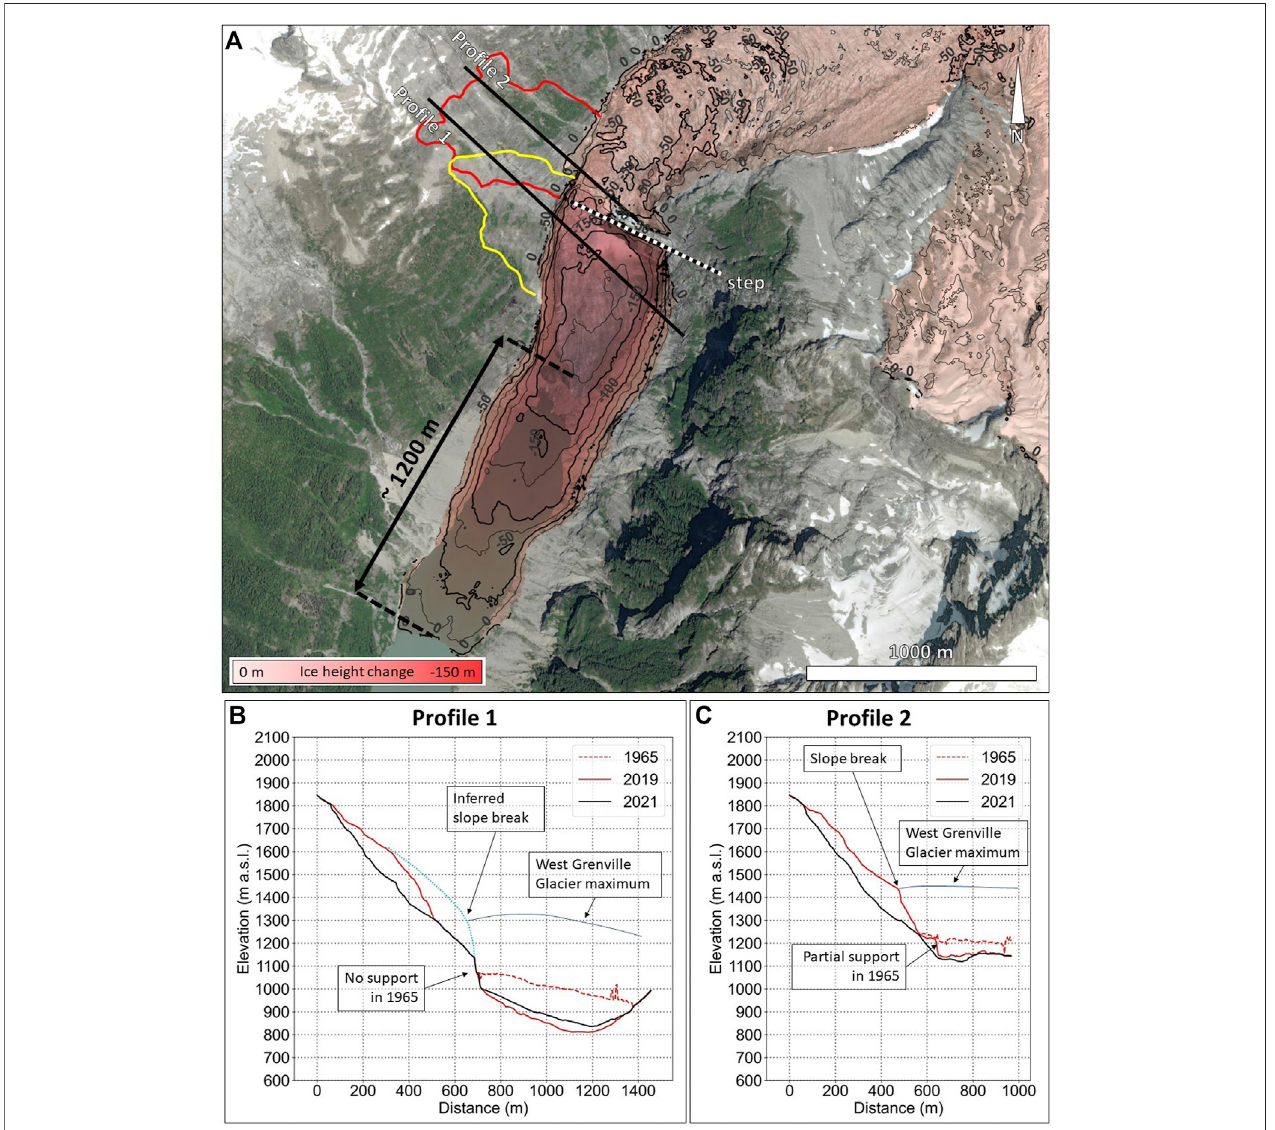
FIGURE 8 | Summary of glacier change analysis. (A) map of the computed change in ice surface elevation between 1965 and 2019. The total retreat of the glacier terminushasbeenestimatedat1200 m.Themaximumchangeiniceelevationof175 moccursimmediatelydownstreamofthegeomorphicstepthatcrossesthevalley near the landslide area. Traces of pro fi les 1 and 2, plotted in (B,C) , are shown. The yellow and red curves outline the old and 2020 landslide events, respectively. (B,C) : pro fi les showing the change in slope and ice surface elevation from 1965 to 2021. Note the lack of support provided by the glacier in 1965 along pro fi le 1, and the limited support provided to the slope in pro fi le 2 in the same year. The slope break (inferred in pro fi le 1) are hypothesized to represent the maximum height of the West Grenville Glacier.